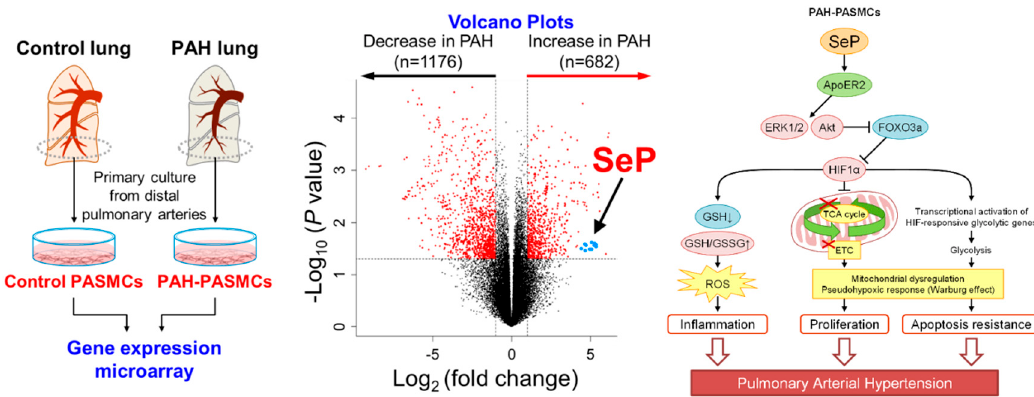
Figure 1. Screening of novel therapeutic targets for pulmonary arterial hypertension and schematic representation of the role of selenoprotein P (SeP). Volcano plots of gene expression variations in PAH-PASMCs and control PASMCs. Blue plots represent probes for SeP. Dashed lines represent an adjusted P value of 0.05 and ± 1-fold change. PAH-PASMCs, pulmonary artery smooth muscle cells harvested from patients with pulmonary arterial hypertension (PAH); ApoER2, apolipoprotein E receptor 2; ERK1/2, extracellular signal regulated kinases 1 and 2; ETC, electron transport chain; FOXO3a, forkhead box protein O3a; GSH, glutathione; GSSG, oxidized glutathione; HIF-1 α , hypoxia inducible factor 1 α ; PAH-PASMCs, pulmonary arterial hypertension-pulmonary artery smooth muscle cells; ROS, reactive oxygen species; SeP, selenoprotein P; TCA cycle, tricarboxylic acid cycle.